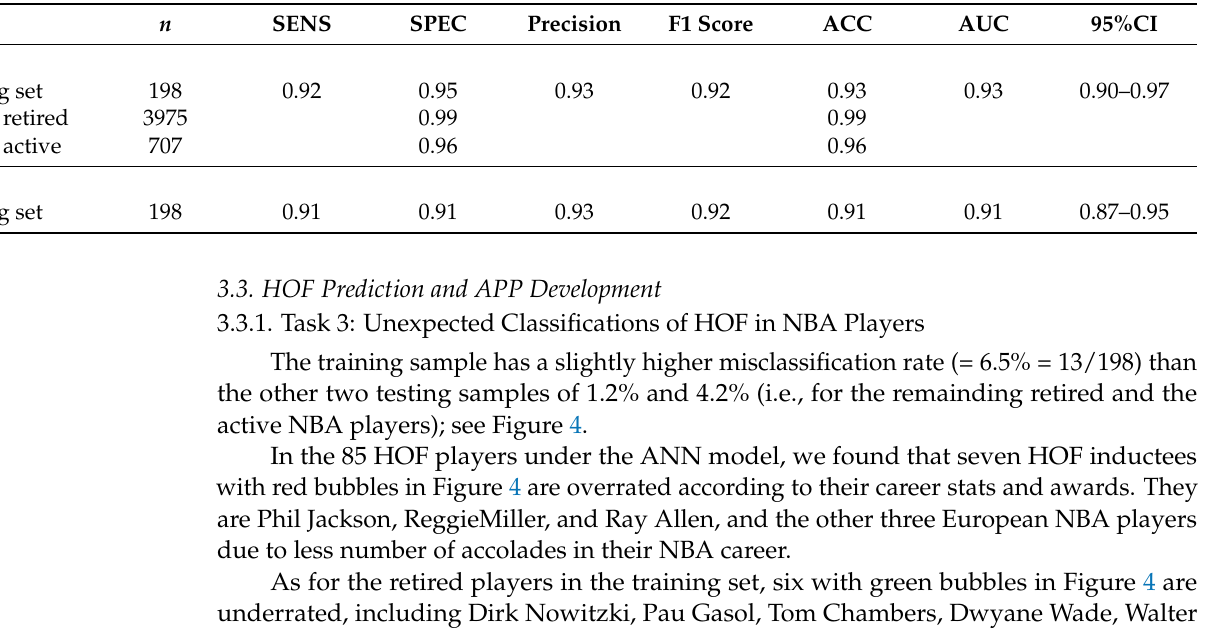
Figure 3. Eligible featured variables extracted from the 27 variables based on the correlation coefficient (>0.1) associated with the Hall of Fame (HOF) label. Table 2. Comparison of statistics in models and